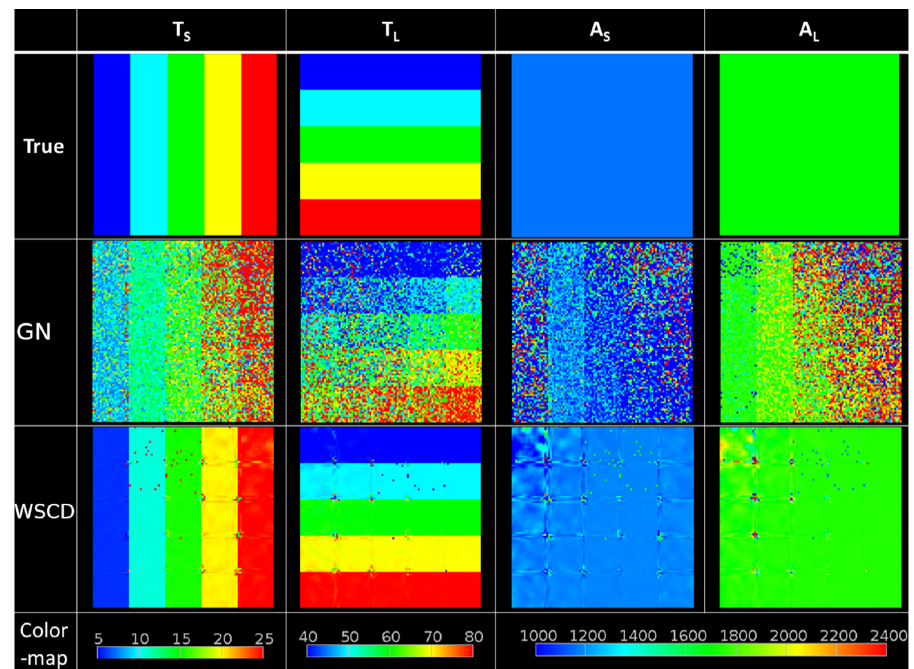
Figure 5. Accuracy of long ( T L ) and short ( T S ) T2 components from simulated data with the WSCD and GN methods. Colors: black, red, and blue denote the true T2, WSCD-reconstructed, and GN- reconstructed values, respectively. Error bars represent the SD. The reconstructed T2 values should be as close as possible to the true T S values of 5, 10, 15, 20, and 25 ms and true T L values of 40, 50, 60, 70, and 80 ms.